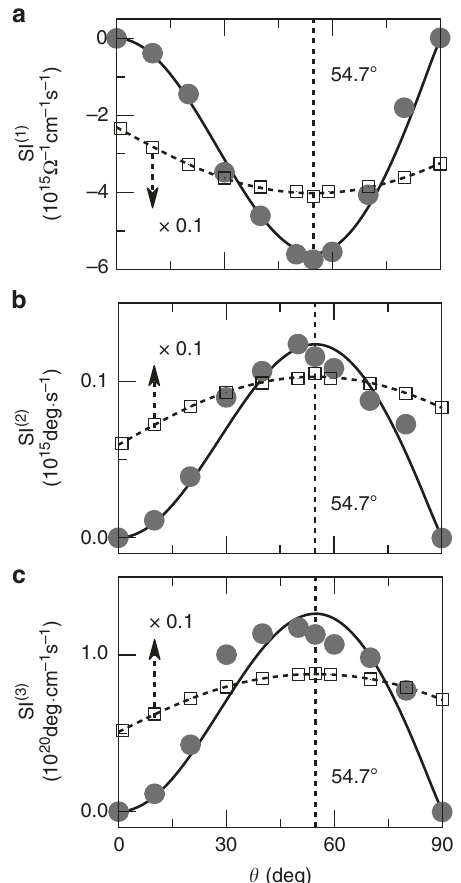
Fig. 5 Spectroscopic hallmarks of the topological magneto-optical effect. For the strained γ -Fe 0.5 Mn 0.5 system with δ ¼ 0 : 95, the magnetic order as encoded in θ imprints on the spectral integrals of a the real part of the off- diagonal magneto-optical conductivity, and on the spectral integrals of b Kerr and c Faraday rotation angles. Solid circles and open squares represent the data for the chiral noncoplanar antiferromagnet and for the collinear ferromagnetic state, respectively. In the latter case, the magnetization changes with θ from the [001] to the [110] crystallographic direction. Spin – orbit coupling is included in the ferromagnetic case, for which the resulting integrals are divided by an overall factor of 10. The solid lines are fi ts of the obtained angular dependence to the scalar spin chirality, whereas the dashed lines are computed based on the magnetocrystalline anisotropy function with hexagonal symmetry, K 0 þ K 1 sin 2 ð ϕ Þ þ K 2 sin 4 ð ϕ Þ where ϕ ¼ θ (cid:3) 54 : 7 (cid:1) , as the strain is applied along the [111] direction of cubic